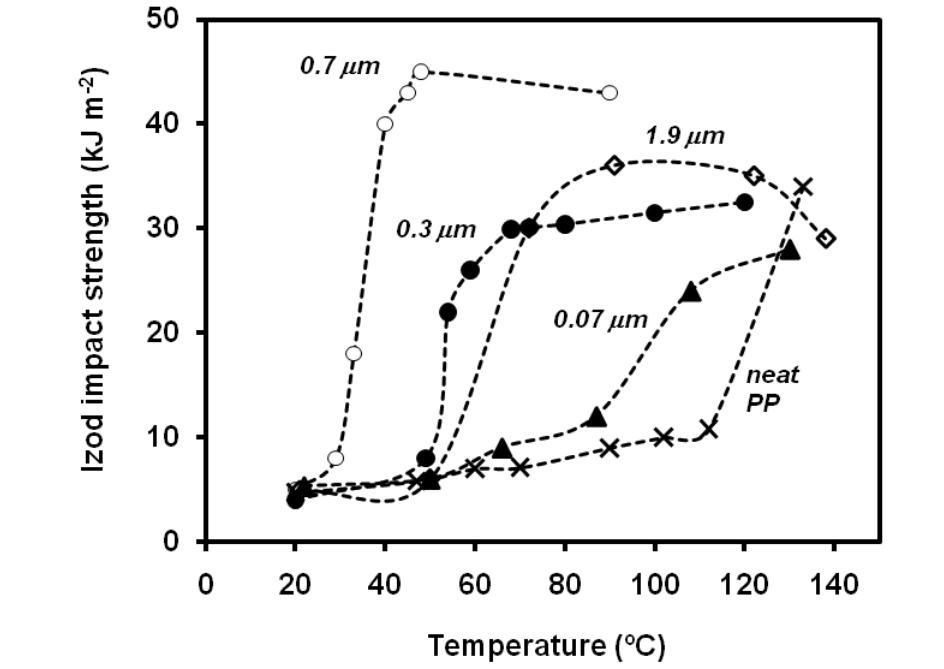
Figure 22. Influence of particle size and temperature on the values of notched Izod impact strength of PP-CaCO composites (adapted from 3